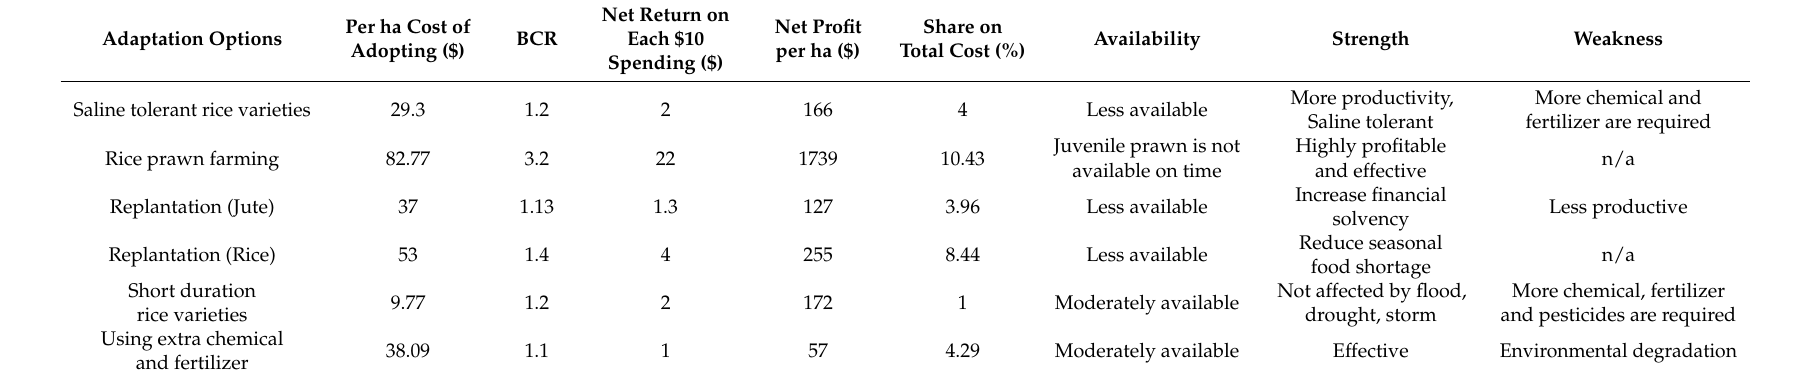
Table 9. ADM for the agriculture